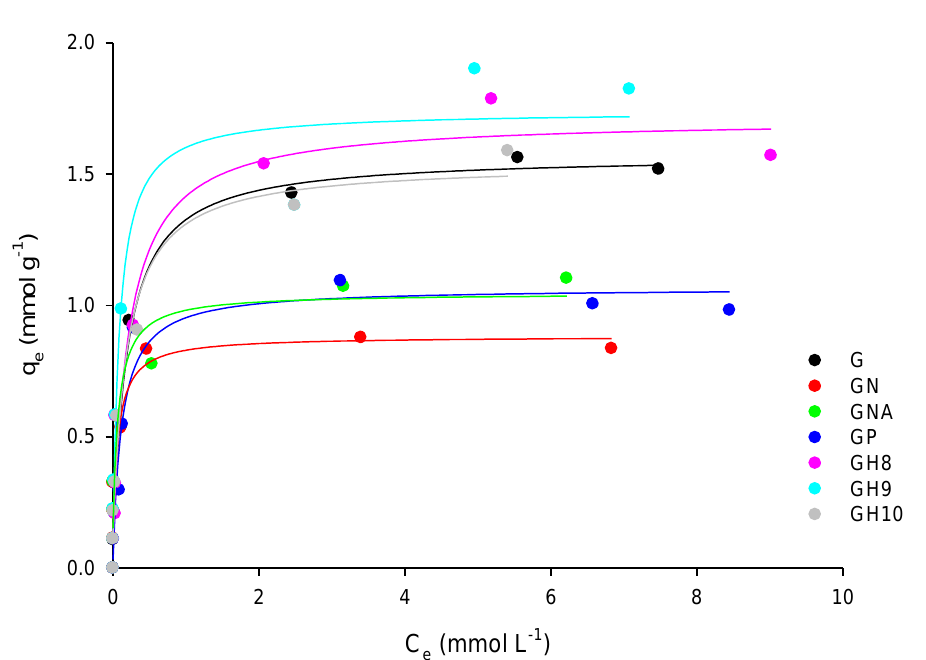
Figure 6. The phenol adsorption isotherms on activated carbons at 291 K. The lines correspond to the adjustment of adsorption data for the modified model of Langmuir.